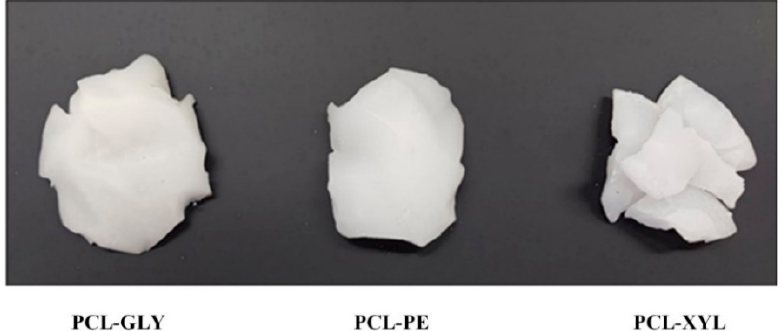
Figure 1. Recovered new branched PCL-based copolymers immediately after their synthesis.